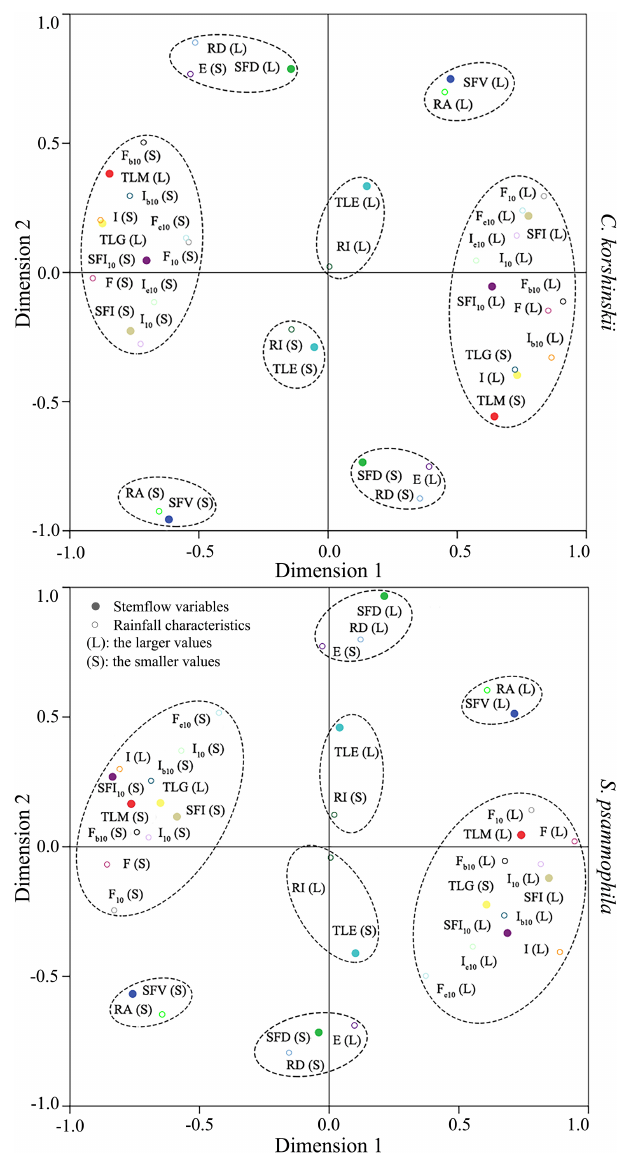
Figure 5. Correspondence maps of stemflow variables with rainfall characteristics for C. korshinskii and S. psammophila